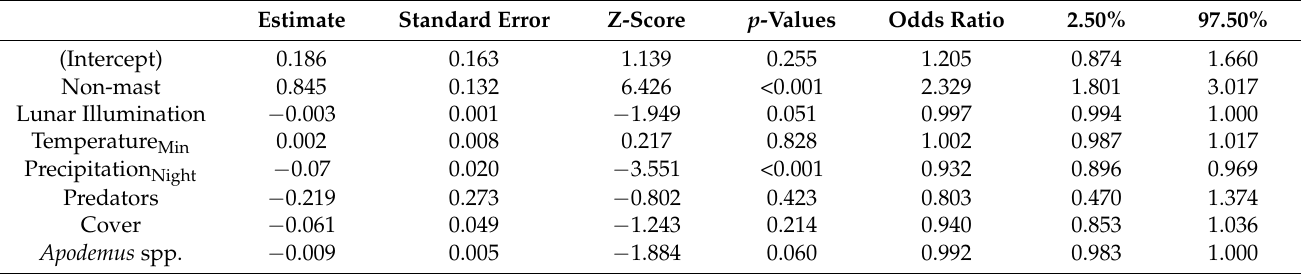
Table 1. Effects of seven environmental predictors on the nocturnal activity of bank voles, Clethriono- mys glareolus